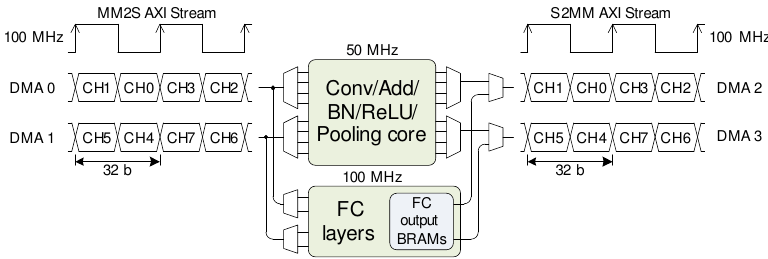
Figure 9. Four synchronous AXI streams: two to PL side; two to RAM.